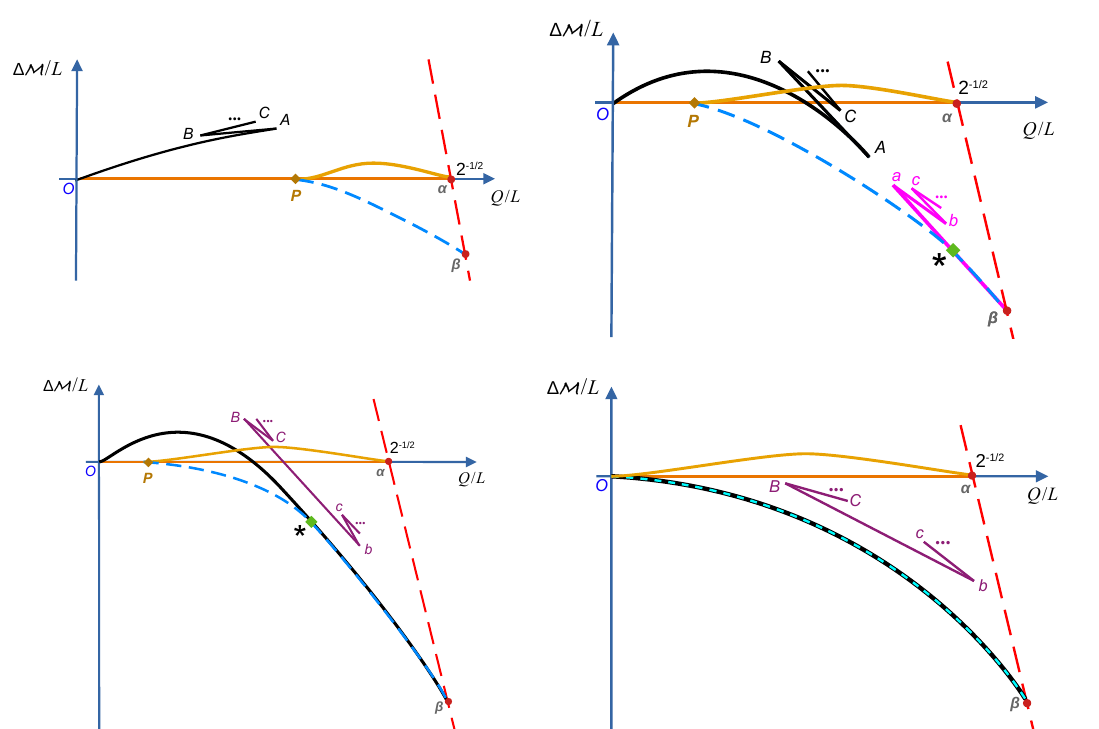
Figure 2 . Sketch of the quasilocal phase diagram for black holes and solitons and as we span relevant windows of scalar field charge e . The critical charges are such that 0 < e . < e γ < e c < e NH S The quantity ∆ M is the quasilocal mass difference between a given solution and an extremal RN BH that has the same quasilocal charge Q /L . Hence the orange line at ∆ M = 0 describes the extremal RN solution that must have Q /L ≤ 2 − 1 / 2 to fit inside the box. The red dashed line represents the maximal quasilocal charge of solutions that can fit inside the box. It intersects the extremal RN line at Q /L = 2 − 1 / 2 . Non-extremal RN BHs confined in the box have ∆ M > 0 and fill the triangular region bounded by Q = 0 and by the orange and red dashed lines (not shown completely). The main soliton family is always given by black curves that start at O . The secondary soliton family is given either by magenta or purple curves. Hairy black holes exist in the region Pαβ enclosed by the yellow merger line Pα (between hairy and RN BHs), the blue curve Pβ where the curvature grows large and the red line αβ . Top-left panel: case e < e < e γ . Top-right panel: NH e γ ≤ e < e c . Bottom-left panel: case e c ≤ e < e . Bottom-right panel: case e ≥ e S S